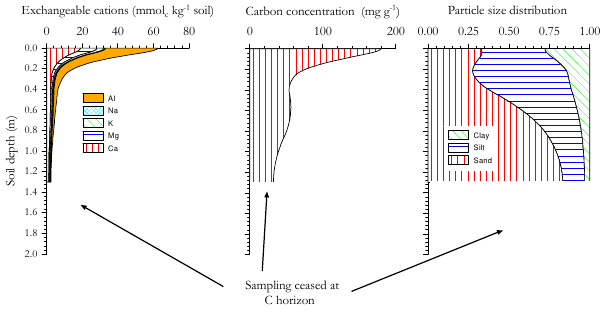
Fig. 19. Profiles of exchangeable cations, soil carbon and texture for a Silandic Andosol (Hyperdystric, Siltic) near the Sumaco volcano, Ecuador